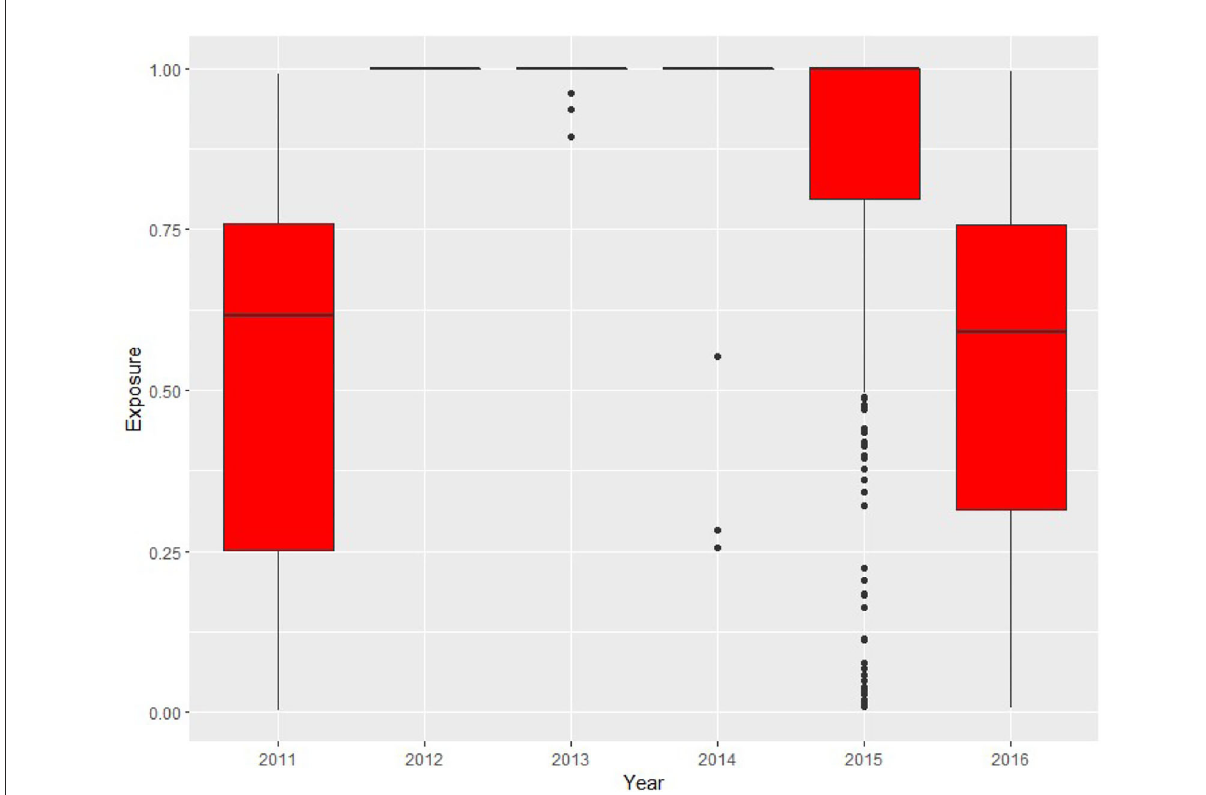
FIGURE1 Box plot for coverage exposure by the